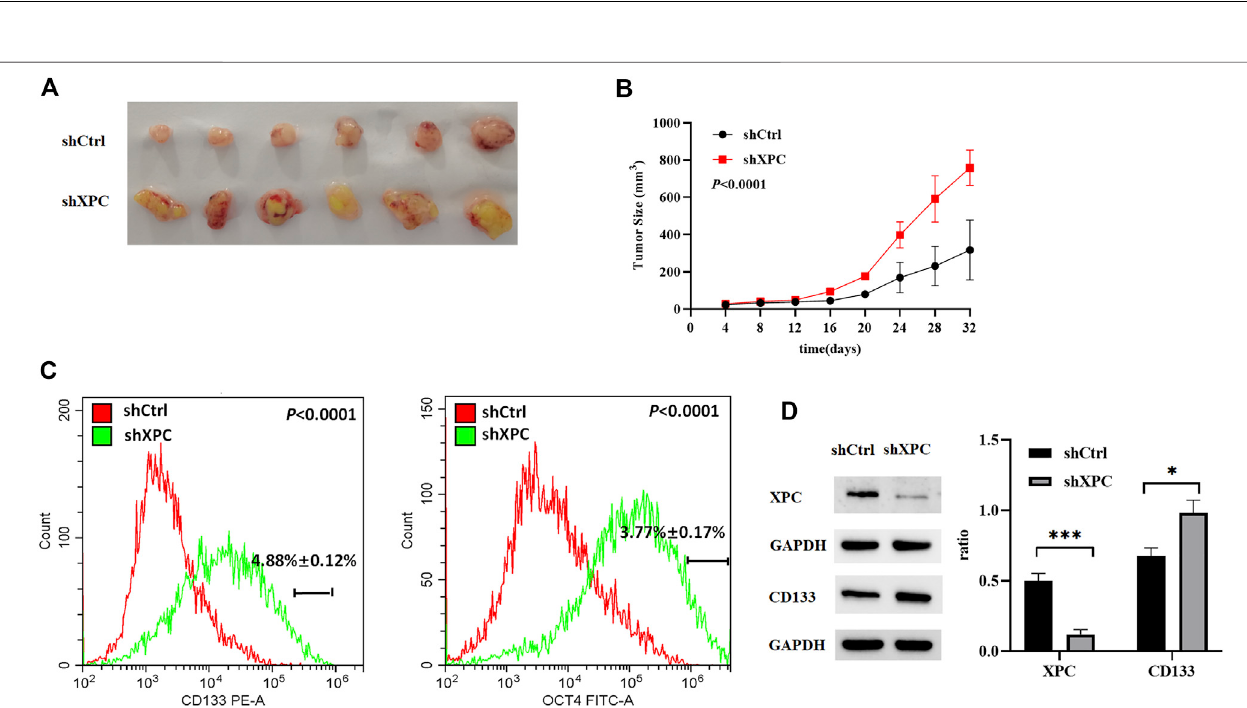
FIGURE 7 | Anti-tumor effect of XPC on A549 tumor-bearing nude mice. (A) . Xenografts were generated by A549 cells (shCtrl), A549 cells with stable XPC knockdown (shXPC). Tumors were removed from mice after 32 days. (B) . Tumor sizes were measured every 4 days. (C) . The expression of CD133 and OCT4 were determined using Flow Cytometry. p < 0.0001(CD133), p < 0.0001(OCT4), A549-shXPC compared with A549-shCtrl. (D) . The expression of XPC and CD133 were determined using Western blotting. The intensity of each band was quanti fi ed using Image J and normalized to. Protein extractions come from xenotransplanted tumor tissue of mice. *** p < 0.001 (XPC), * p < 0.05(CD133), A549-shXPC compared with A549-shCtrl. ( n (cid:1) 6).